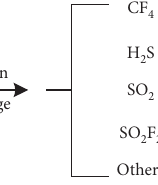
Figure 1: SF 6 and its substitute gas decomposition product process.